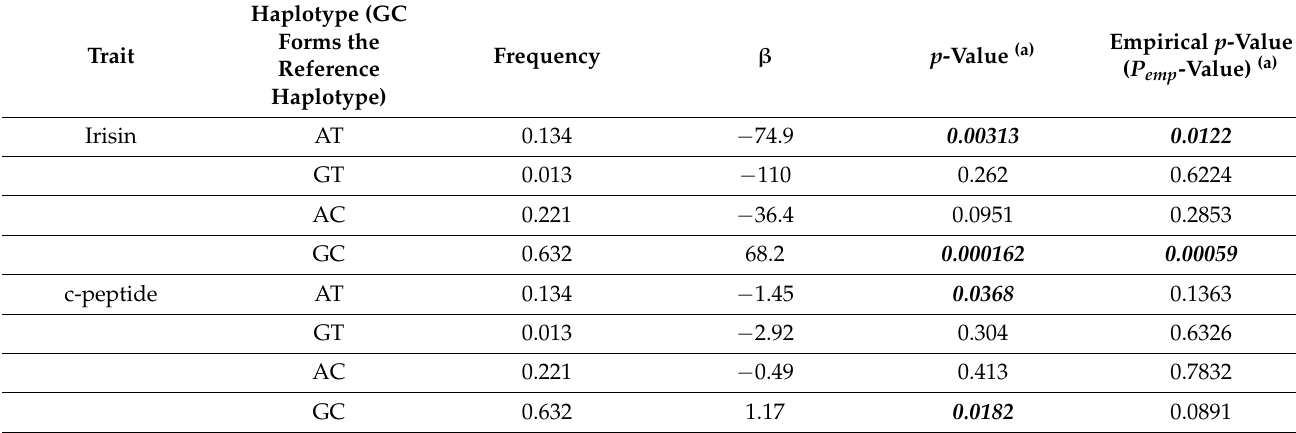
Table 3. Results of association tests for the haplotype of rs1748197-rs12130333 with the levels of c-peptide and irisin. Effect allele at rs1748197_G_A is A and at rs12130333_C_T is T.